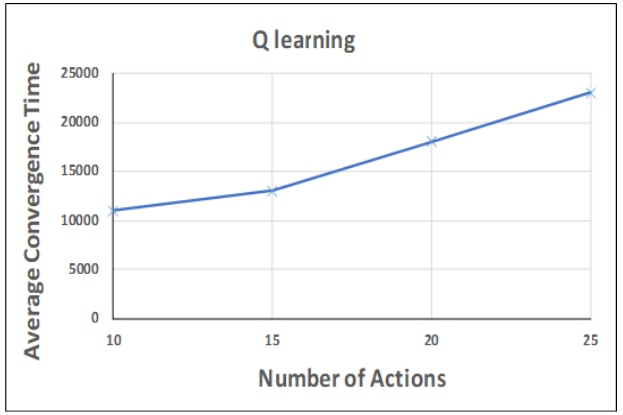
Figure 3. Convergence time as a function of Number of Actions.